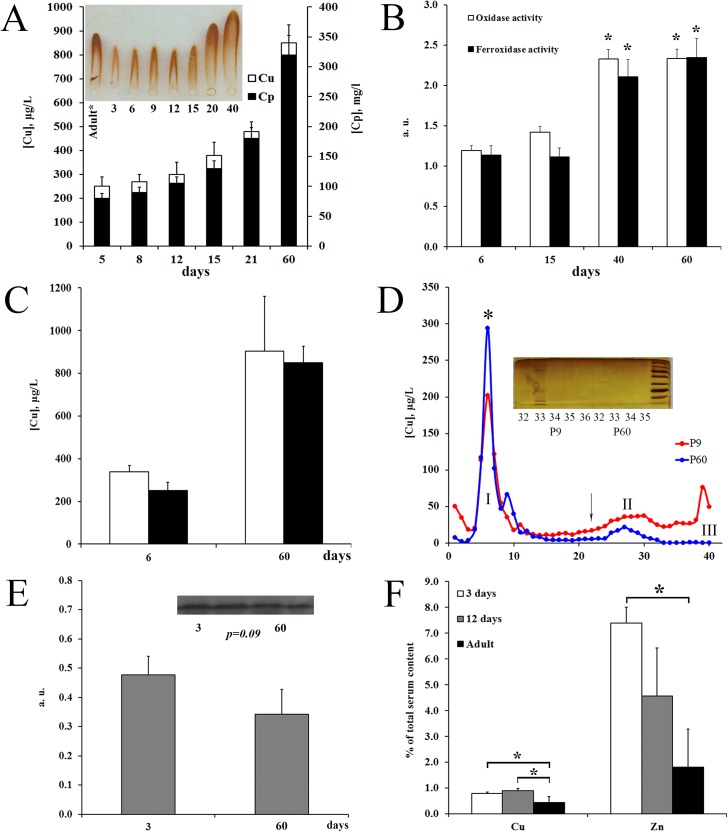
Ontogenetic changes of copper balance in the blood serum of rats.(A) Serum copper concentration and ceruloplasmin protein level increased coordinately during development. Ordinate axis: (left) copper concentration, μg/L (light bars), (right) ceruloplasmin protein concentration measured by rocket immunoelectrophoresis, mg/L (black bars), the means ± SD, n = 5. Inset: the representative protocol of immunoelectrophoresis. *Serum of adult rat was 2-fold diluted. Abscissa axis: age, days. (B) Blood serum oxidase and ferroxidase activities increased after ETCM→ATCM transition. Enzymatic activities were determined by gel-assay and expressed as a. u., the means ± SD, n = 3. Abscissa axis: age, days, *Р<0.05 in comparison with newborns. (C) In the serum of newborn and adult rats, the main copper portion was precipitated with ceruloplasmin. Ordinate axis: copper concentration, μg/L, light bars–actual serum copper concentration; black bars–copper concentration in ceruloplasmin precipitates. (D) Gel-filtration distribution of blood serum copper of P9 (red) and P60 (blue) rats. Ordinate axis: cooper concentration, μg/L; abscissa axis: gel-filtration fraction number. *—position of the maximum oxidase activity. Arrow show eluted position of cytochrome C. Inset: 12% SDS-PAGE of fractions from peak III of P9 and P60 rats. The samples were treated with SDS and 2-mercaptoethanol at 95°C, 5 min. Gel was stained with AgNO3. Right lane: molecular weight calibration markers from 3.4–100 kDa (ThermoScientific, cat. N26632, USA). (E) Metallothionein (MT) presents in the serum of newborn and adult rats. Upper: WB protocol of blood serum P9 and P60 rats with antibodies to MT (samples content 1.0 μl serum); below: relative level of MT in newborn and adult rats, the means ± SD (n = 3). (F) Serum copper and zinc are precipitated by antibodies to MT. Ordinate axis: Copper or zinc content in MT precipitates, % from atomic concentration copper or zinc in serum (n = 2).